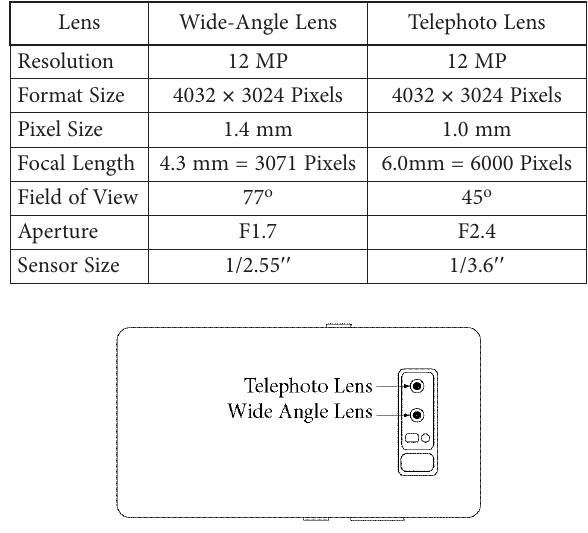
Figure 1. Dual camera system